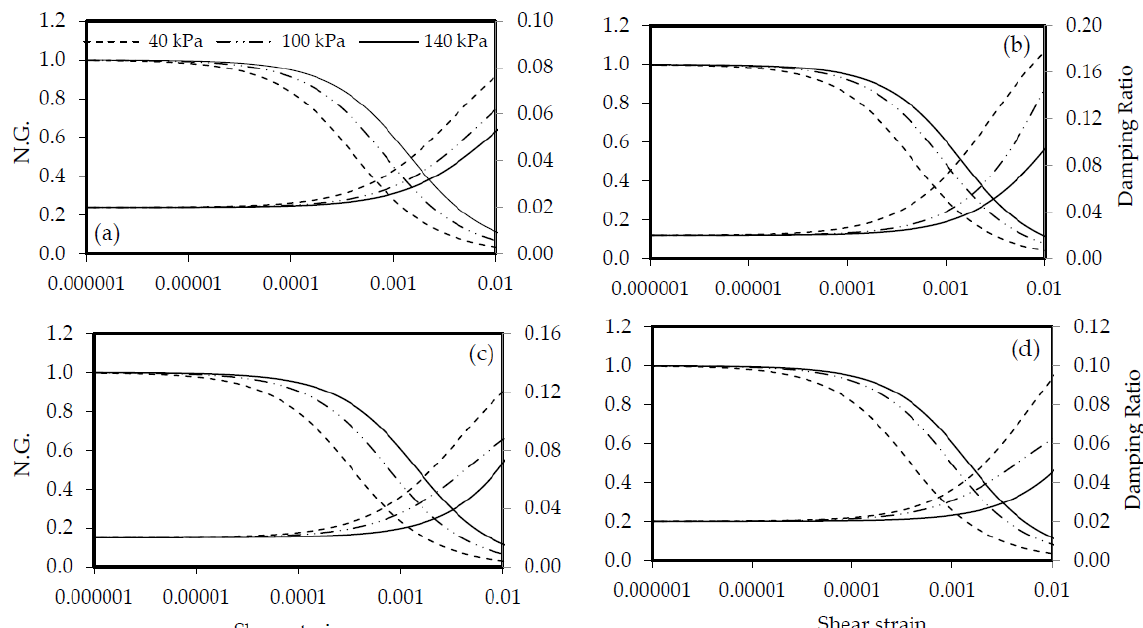
Figure 6. Proposed degradation models for normalized shear modulus (N.G.) and damping ratios for ( a ) sample SA; ( b ) sample SB; ( c ) sample SC; ( d ) sample SD.